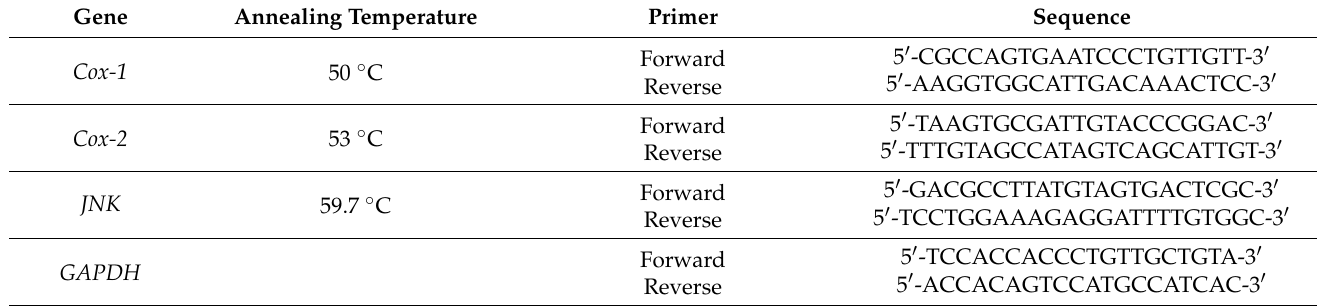
Table 1. The annealing temperatures and primer sequences for the genes of